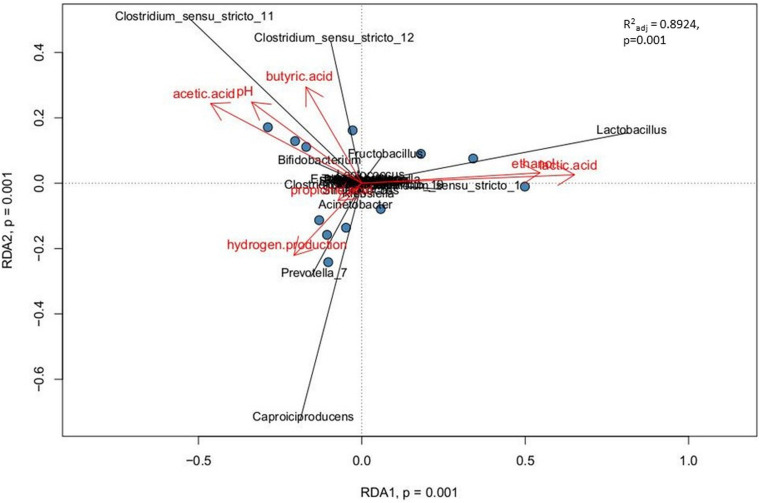
Correlations between the non-gaseous fermentation products, pH of the effluents from bioreactors and the dominant bacterial taxa presented as canonical Redundancy Analysis (RDA) for PBR1 through PBR5. Permutation tests (ANOVA) for RDA, for individual axes, and adjusted coefficients of determination R2adj were calculated with the vegan package.